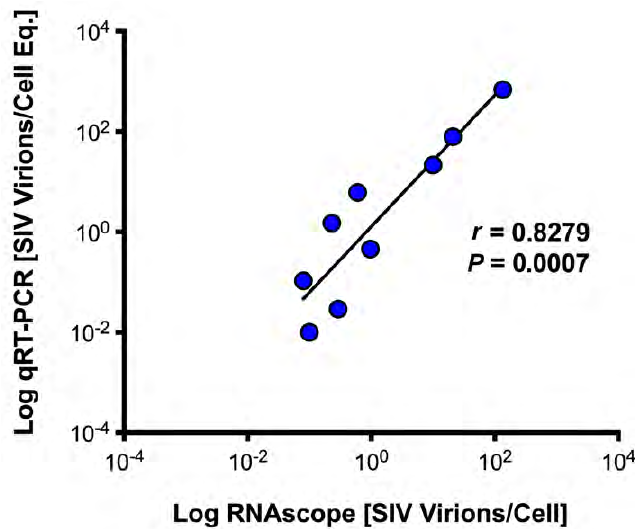
Figure 2. Next-generation RNAscope ISH is capable of detecting individual viral particles in tissues. (A) Low (top panel) and high (bottom panel) magnification images of a lymph node from chronically SIV+ rhesus macaque (RM) showing vRNA+ cells and follicular dendritic cells (FDC)-bound viral par- ticles within the B cell follicle (BCF) (left panel) and the complete loss of signal after RNase pretreatment (right panel). Scale bars = 200 µm. (B) SIV binding to the surface of SupT1 CCR5-Hi cells. Images from 10-fold dilutions of concentrated SIV demonstrating increased detection of individual viral particles by RNAscope (top panel) compared to less discriminating chromogenic in situ hybridization (C-ISH) (mid- dle panel) and radiolabeled in situ hybridization (R-ISH) (bottom panel). Right panel shows high magni- fication images of chronic SIV+ RM lymph node from subjacent sections showing productively infected vRNA+ cells (arrows) and individual viral particles by RNAscope (top), but lack of clear viral particle discrimination using C-ISH (middle) and R-ISH (bottom). Scale bar = 50 µm. (C) The number of viral particles bound to SupT1 CCR5-Hi cells quantified by qRT-PCR is strongly correlated to the number of virions quantified by RNAscope. Data were log10 transformed, and P values were based on associations between paired comparisons using the Pearson’s Correlation